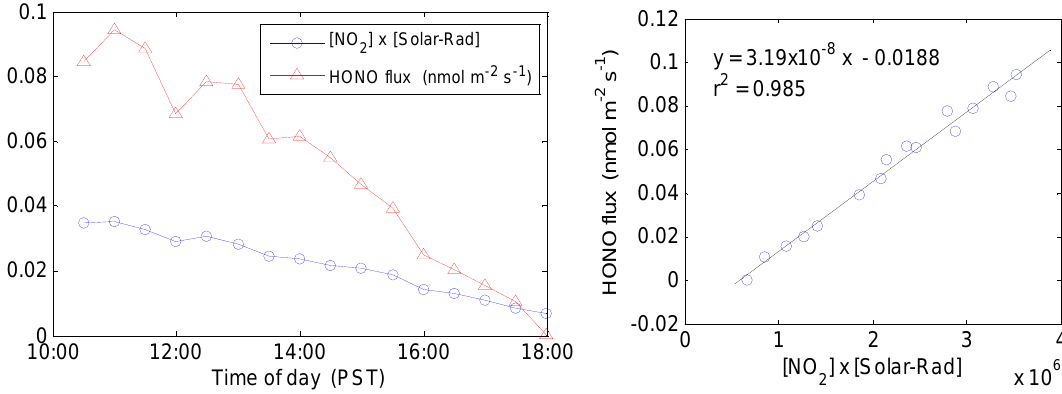
Fig. 4. Left: mean diurnal variations (in 30min intervals) of HONO flux (in nmolm − 2 s − 1 , red triangles) and the product (multiplied by a factor of 1 × 10 − 8 , blue circles) of [NO 2 ] (in pptv) and solar radiation (in Wm − 2 ) . Right: scatter plot of HONO flux versus the product of [NO 2 ] and solar radiation. Data are shown for CalNex 2010 for hours between 10:00 and 18:00 (Pacific Standard Time, PST) when the boundary mixing layer was expected to be fully developed.